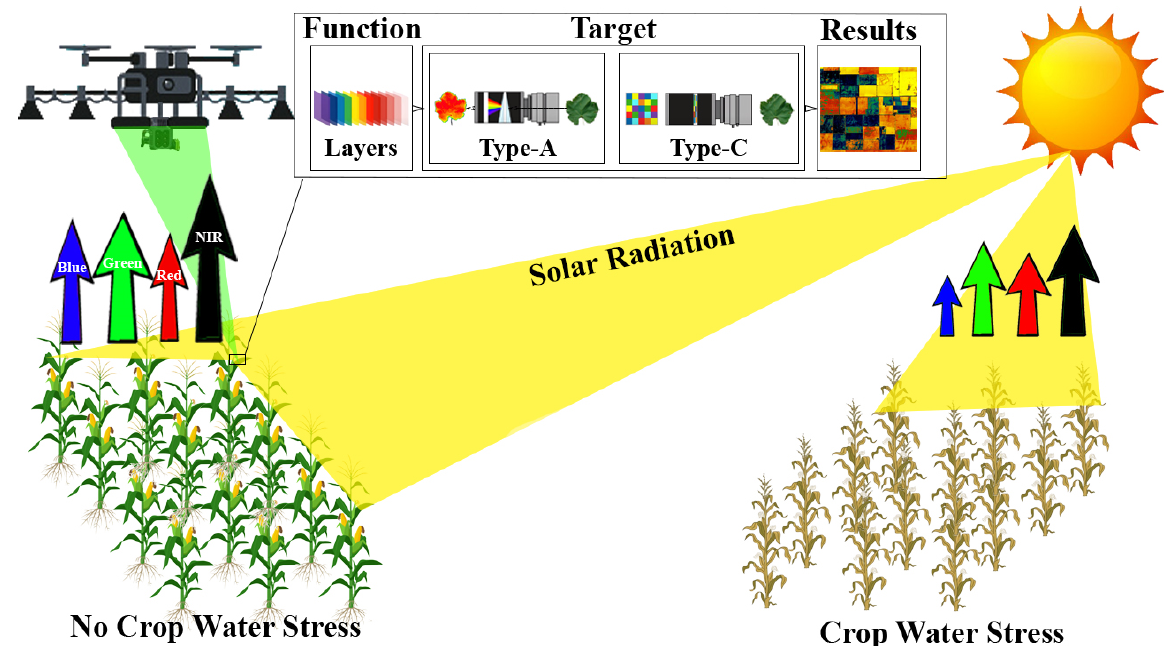
Figure 5. Crop water stress estimation using the multispectral remote–sensing system.